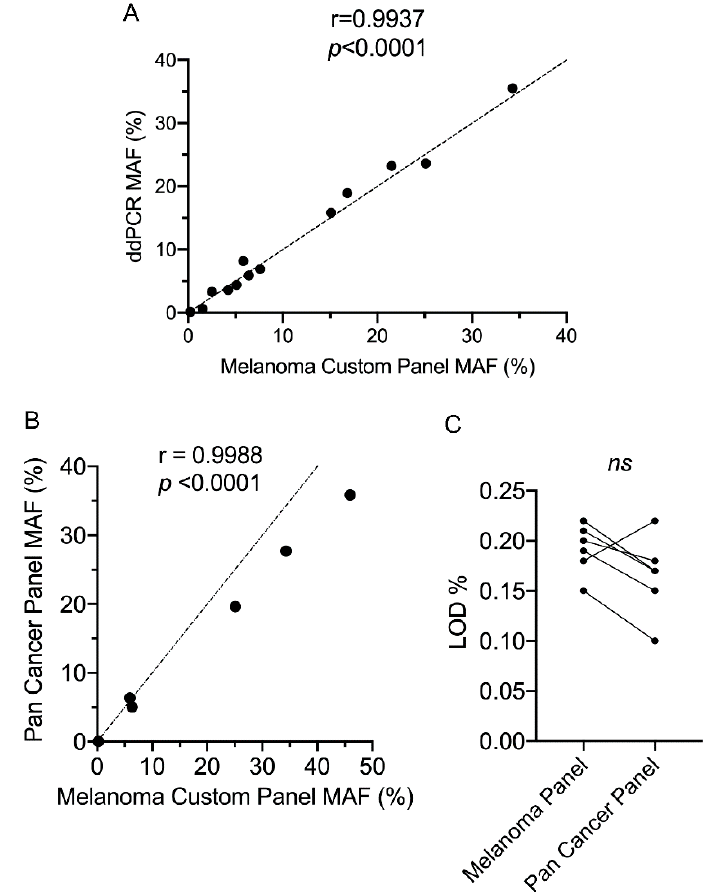
Figure 6. Validation of the custom melanoma panel. ( A ) Correlation of mutant allele frequency (MAF) determined by the melanoma custom panel versus ddPCR analysis. ( B , C ) Comparison of custom melanoma and Oncomine pan cancer targeted NGS panels. ( B ) Correlation of MAF based on mutations detected by both panels. ( C ) Pairwise comparisons of limit of detection (LOD) for matched mutations detected using both assays. For patient samples tested along with NGS and ddPCR data refer to Tables S8 and S9. Pearson correlation coefficient analysis and parametric paired t -test were performed.